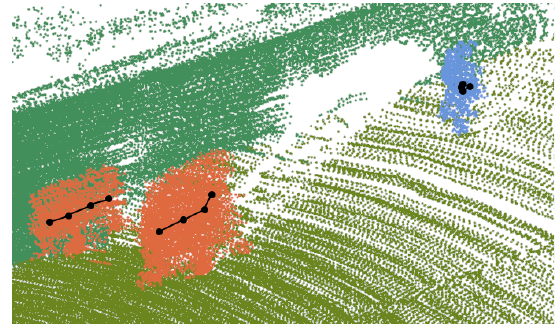
Figure 7: Blobs of two moving pedestrians (orange) and a stand- ing person (blue) on the merged and segmented point cloud. marked with